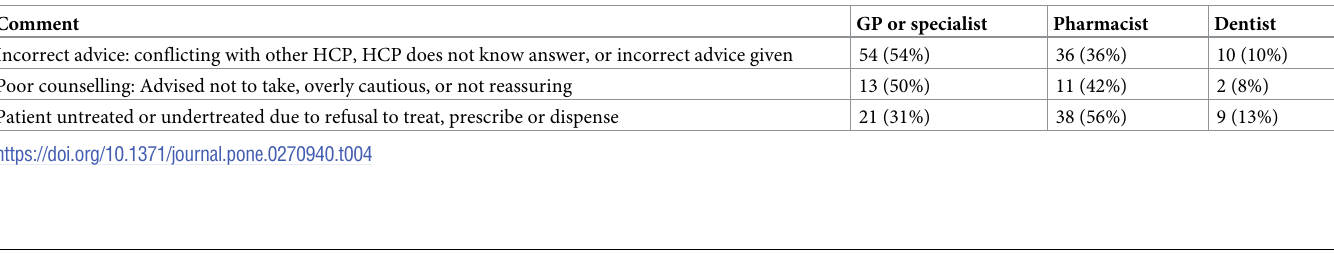
Table 4. Number of comments by patients regarding HCP advice by